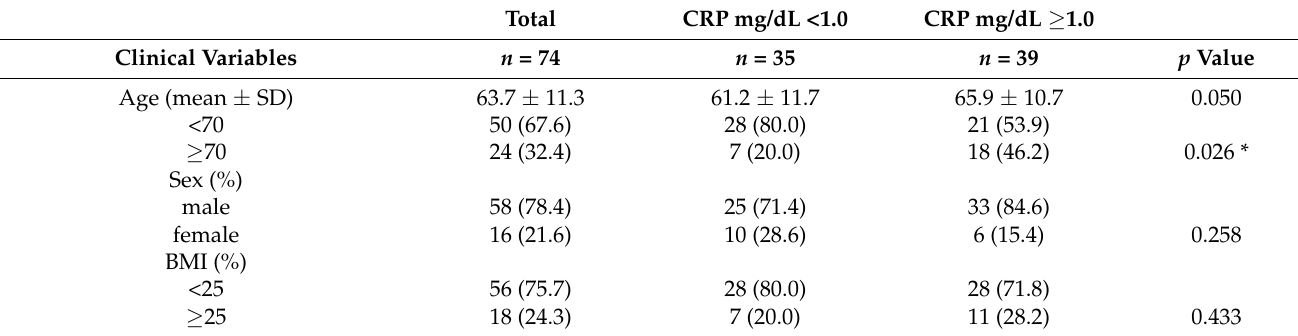
Figure 1. Receiver operating characteristic (ROC) curves of serum C-reactive protein (CRP: mg/dL) to predict lethality. The Youden index (* in the curve) identified a CRP of 1.0 mg/dL as an optimal cut-off value. Table 2. Patient characteristics at the nitiation of ipilimumab plus nibolumab in 74 mRCC patients.